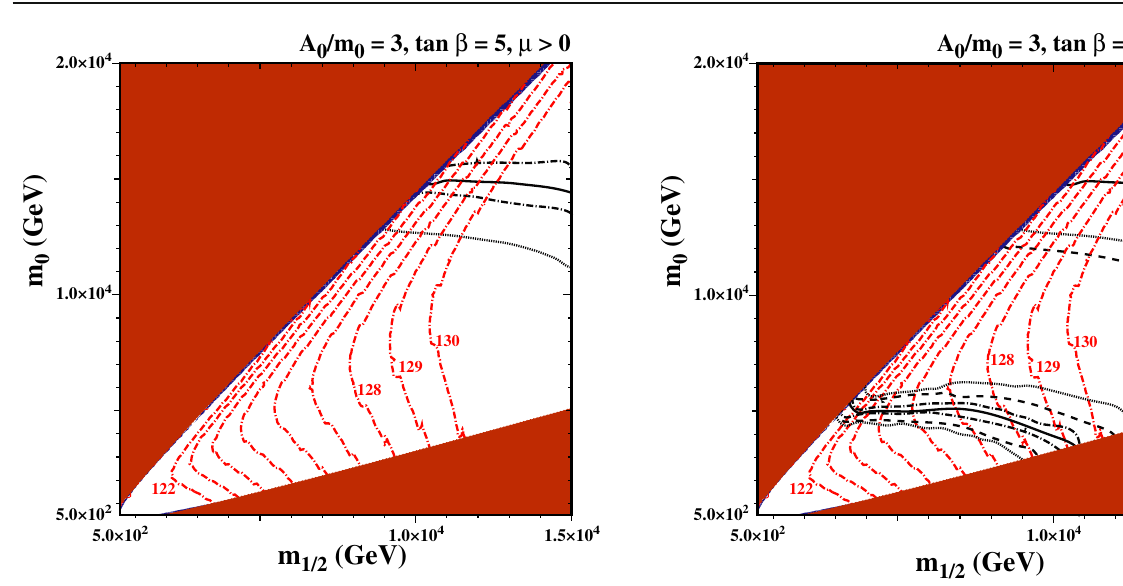
Fig. 3 Sensitivity of the p → K + ¯ ν lifetime to α s , assuming tan β = 5 , A 0 / m 0 = 3 ,μ > 0 in the CMSSM with GUT-scale universality. In the upper set of curves (with c = 0), the solid black curve corresponds to the current lower limit of 0 . 066 × 10 35 yrs on τ( p → K + ¯ ν) for central values of the matrix elements and model parameters, and the black dashed lines correspond to the variation of α s within one standard deviation: α s = 0 . 1181 ± . 0011. The dotted curve corresponds to the shift in the solid curve when the decay rate is decreased by σ tot . In the lower set of curves, the coupling associated with the dimension 5 operator is non-zero, and the meanings of the curves are similar. Also shown is the propagated uncertainty in α s alone, shown by the dot- dashed curves, which are now clearly distinct from the dotted curves using σ tot